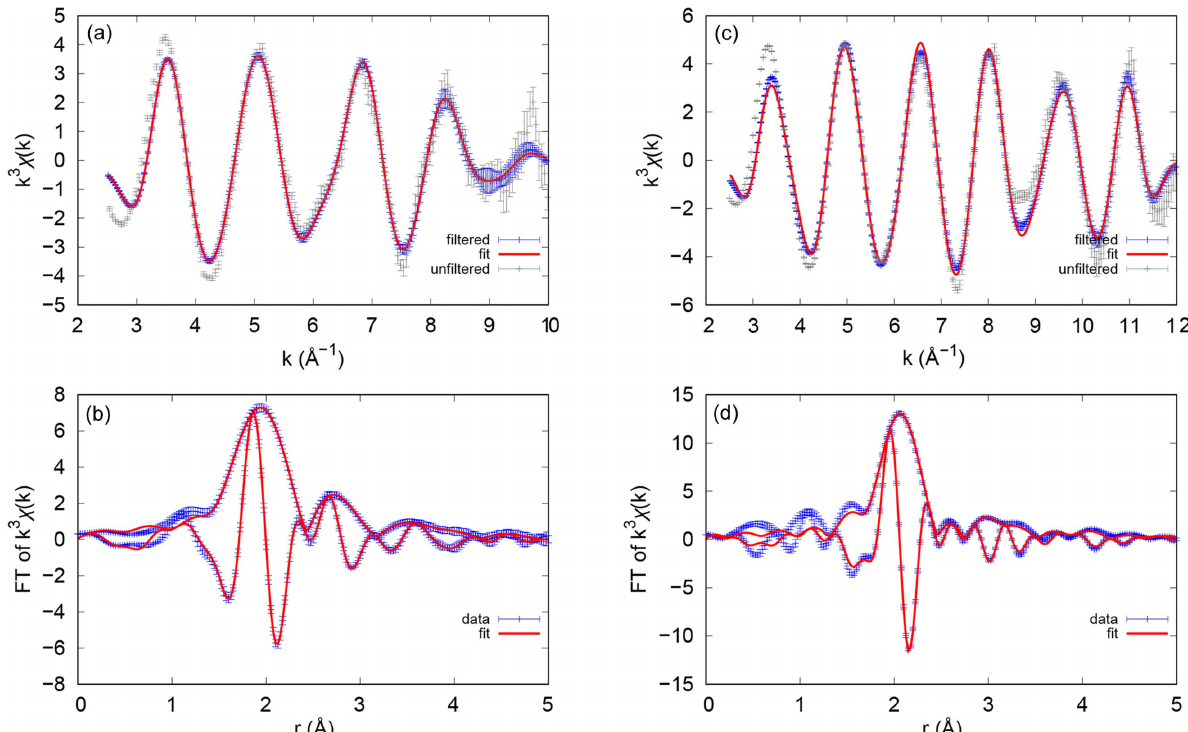
Figure 3 EXAFS data and fit (top) and Fourier transform of the k -space data and fit (bottom) for Bk(III)-343-HOPO and Pu(III)-343-HOPO. ( a , b ) Free fit, except fixed multiple scattering peak amplitudes, for Bk(III)-343-HOPO. ( c , d ) Pu(III)-343-HOPO fit with multiple scattering paths fixed. Error bars for the raw, unfiltered data are estimated as the standard deviation of the mean between individual traces. Note that comparison between fit and data in k - space should be to the filtered data, which has been back-transformed over the fit